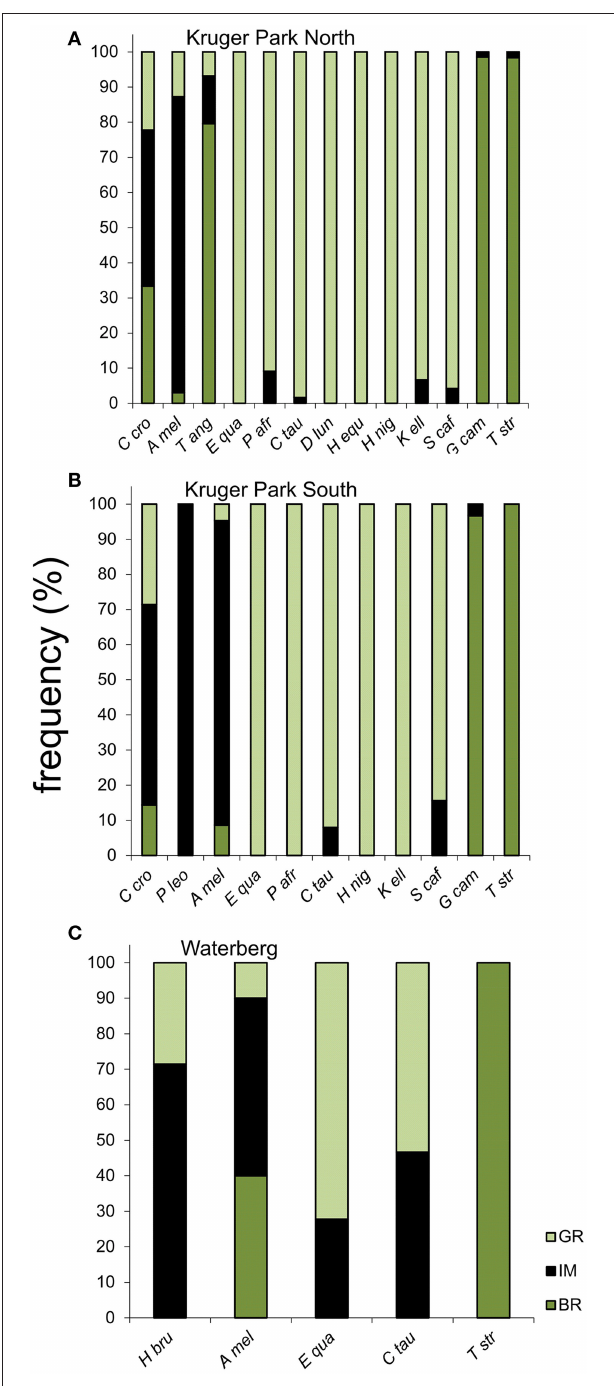
FIGURE 3 | Frequency distributions of prey types across individual carnivores and herbivores estimated from fecal stable carbon isotope content of mammals from three southern African savanna habitats (A, Kruger Park North; B, Kruger Park South; and C, Welgevonden Private GameReserveintheWaterbergregion). See Table 1 forfullspeciesnames.